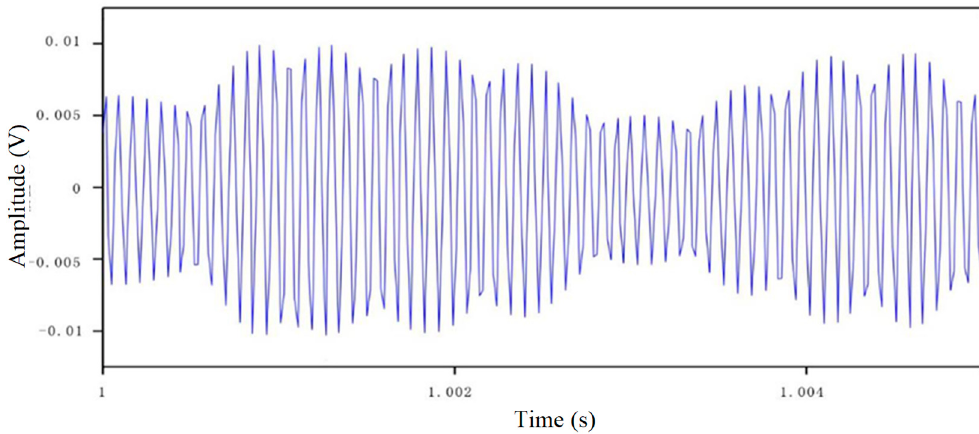
Figure 12. Time domain diagram of sine signals received by a smart aggregate sensor.